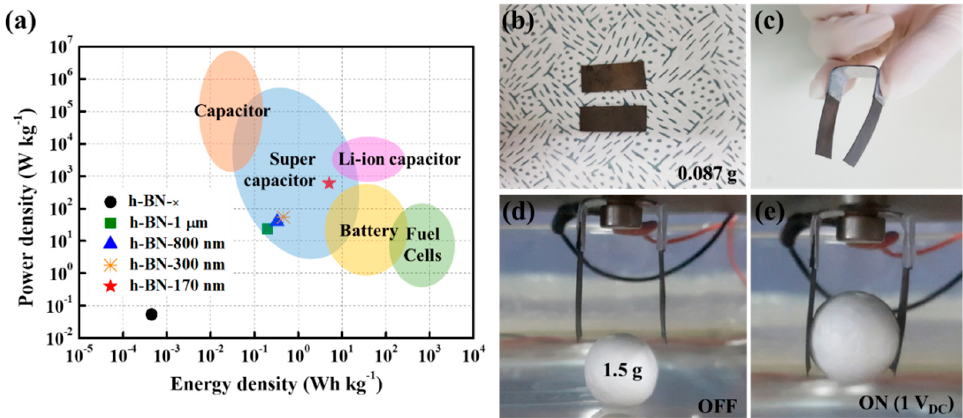
Figure 6. ( a ) Average power and energy densities of IEAP actuators without insulating layers (h- BN − ×) and with h-BN insulating layers with different particle sizes (1 μ m, 800 nm, 300 nm, and 170 nm) compared to requirements of various industrial fields. Images of ( b ) sheets of IEAP actuator with h-BN − 170 nm used in ( c ) two-finger gripper. Images taken ( d ) before and ( e ) after grasping an object at 1.0 V DC .